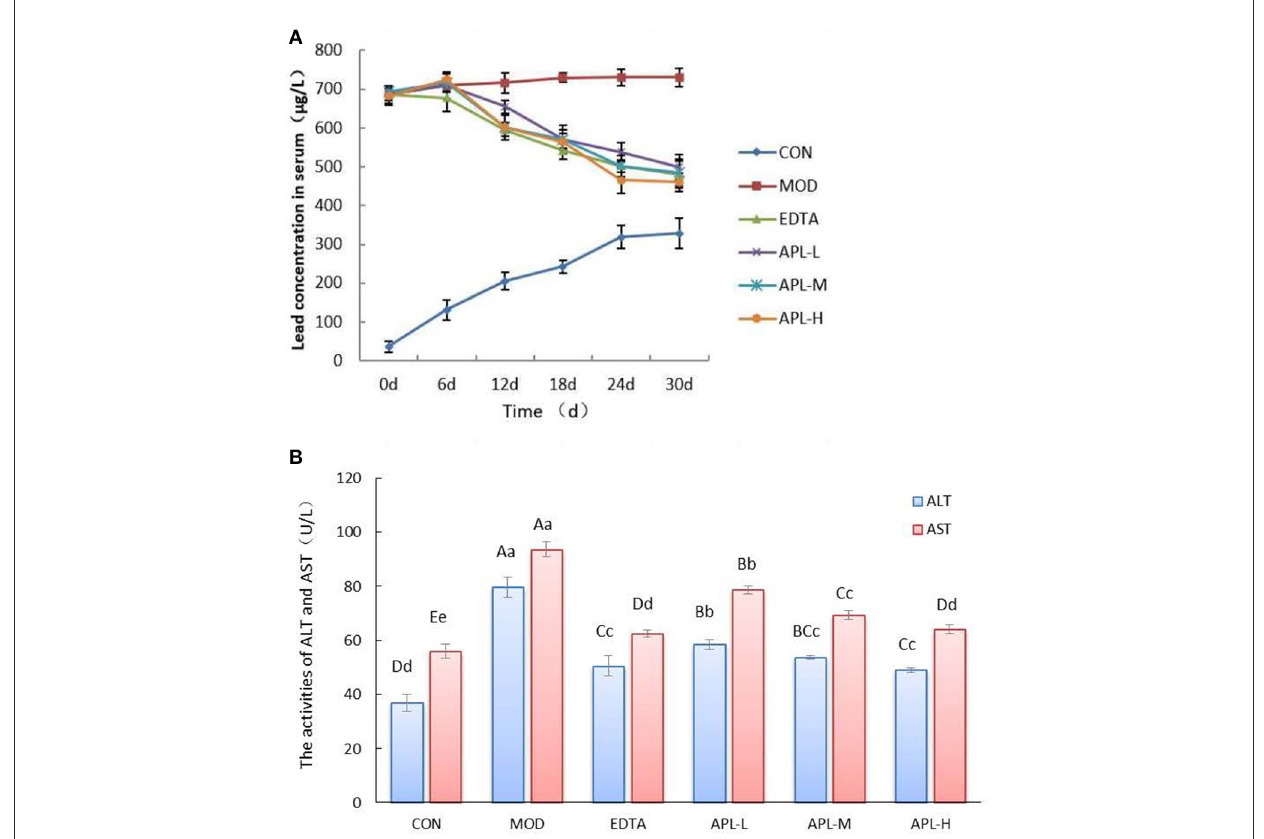
FIGURE4 APL-elicited inhibition of rise in serum biochemical indexes in different experimental groups following lead administration. (A) Time course of serum lead concentration; (B) Serum enzyme (ALT and AST) activities. APL-L, APL-M, and APL-H represent 40, 80, and 160mg APL/kg body weight, respectively. Results are presented in mean ± standard deviation ( N = 5/group). a, b, c indicated the significant difference ( p < 0.05), A, B, C indicated the significa.nt difference ( p < 0.05).